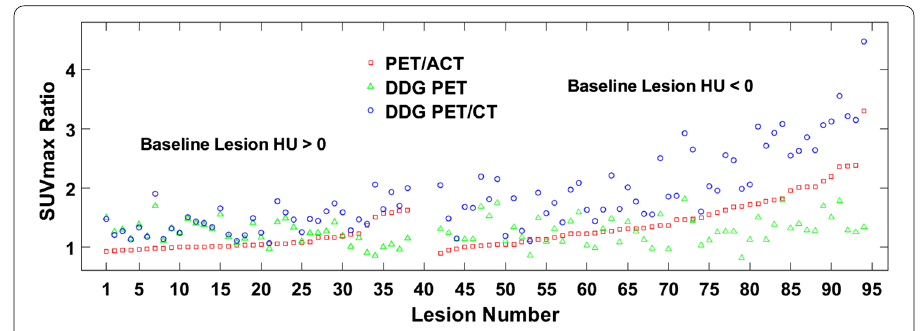
Fig. 3 SUV max ratios relative to baseline PET/CT. The ratios for each PET/CT method are plotted in increasing order based on the value for PET/ACT, but separated into two groups with baseline lesion mean HU > 0 on the left (#1–38) and baseline lesion mean HU < 0 on the right